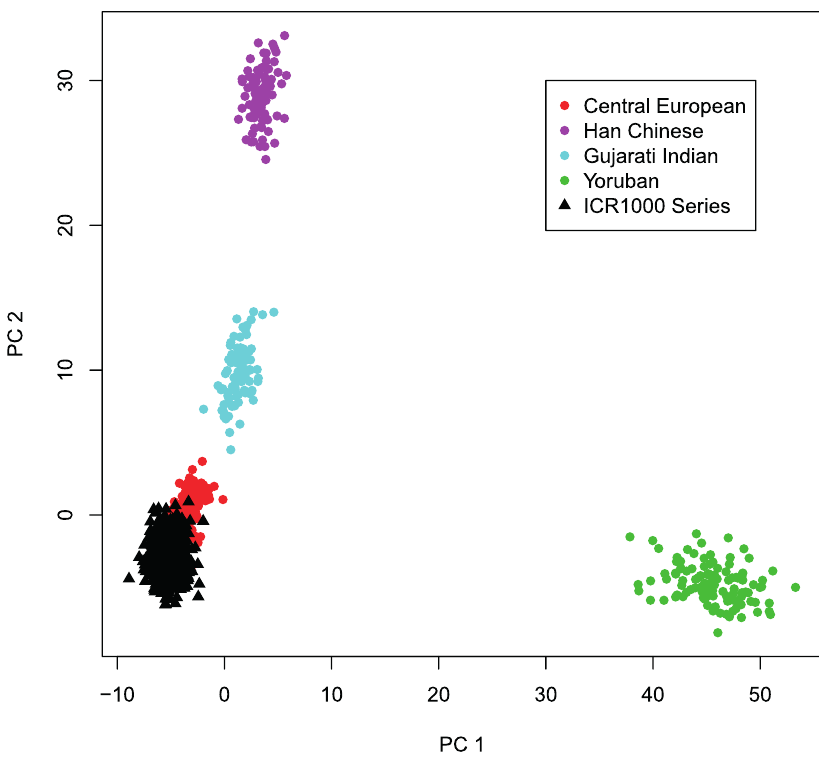
Figure 1. Population structure of the ICR1000 UK exome series. Plot of first and second principal components from PCA using HapMap populations and the ICR1000 UK exome series showing that the series clusters with the Central European population, with no ethnic outliers.